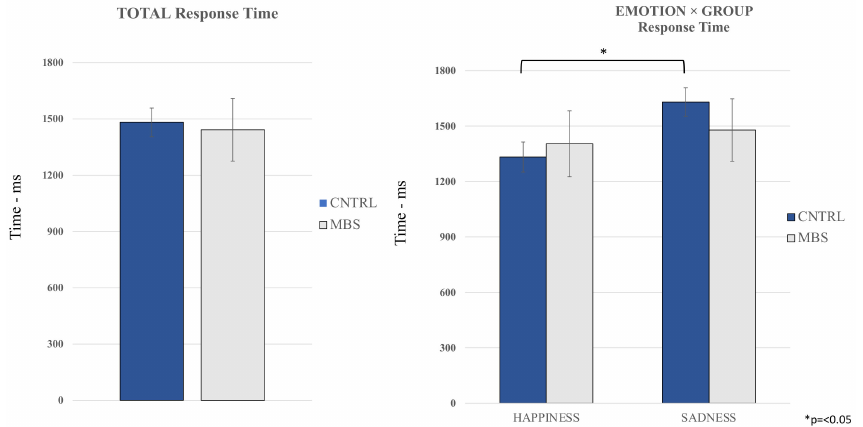
Figure 4. Illustrates the absence of a group effect in terms of response time (left panel), and the emotion by group effect, characterized by faster response times in the control group for happy facial expressions compared with sad